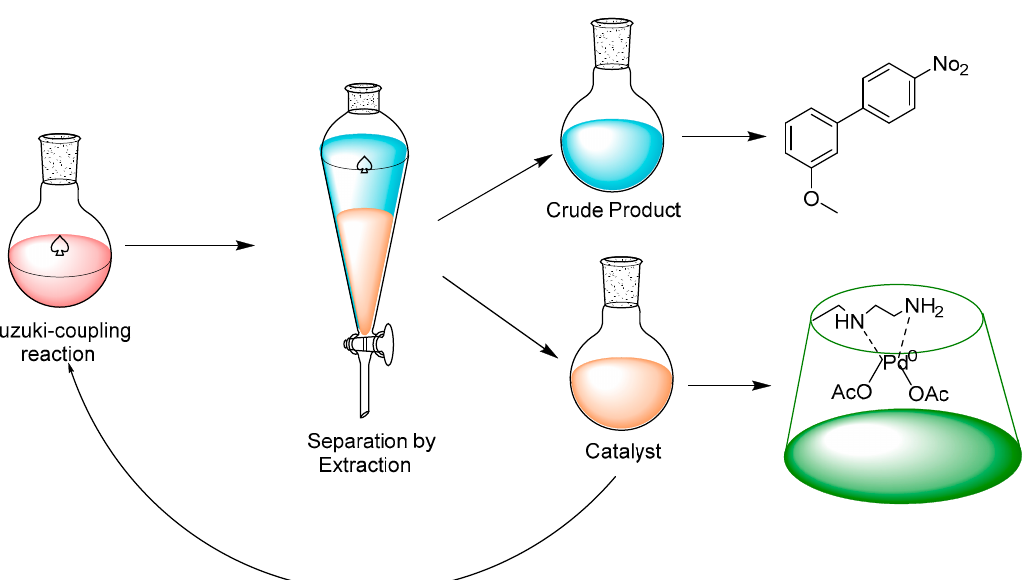
Figure 4. Recycling procedure for PdLn@Et ‐β‐ CD.